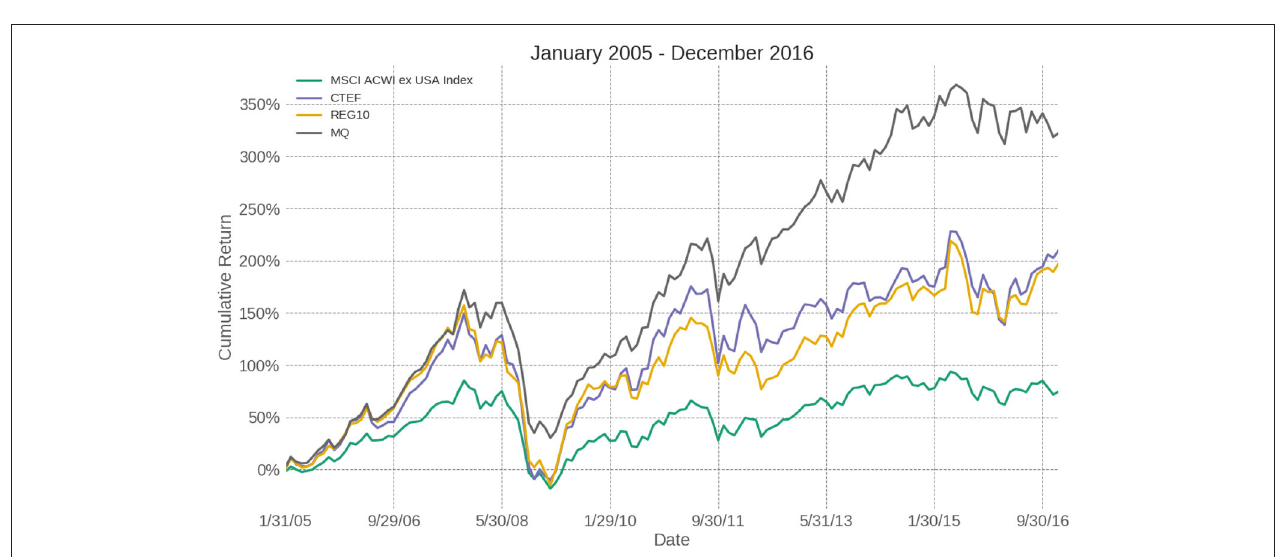
FIGURE 1 | Portfolio performance with GL (global) universe.